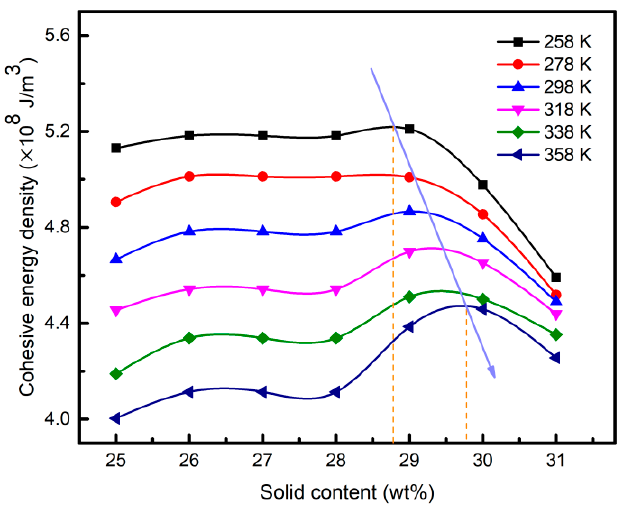
Figure 9. Cohesive energy density of aluminum sols with different amounts of solid content.